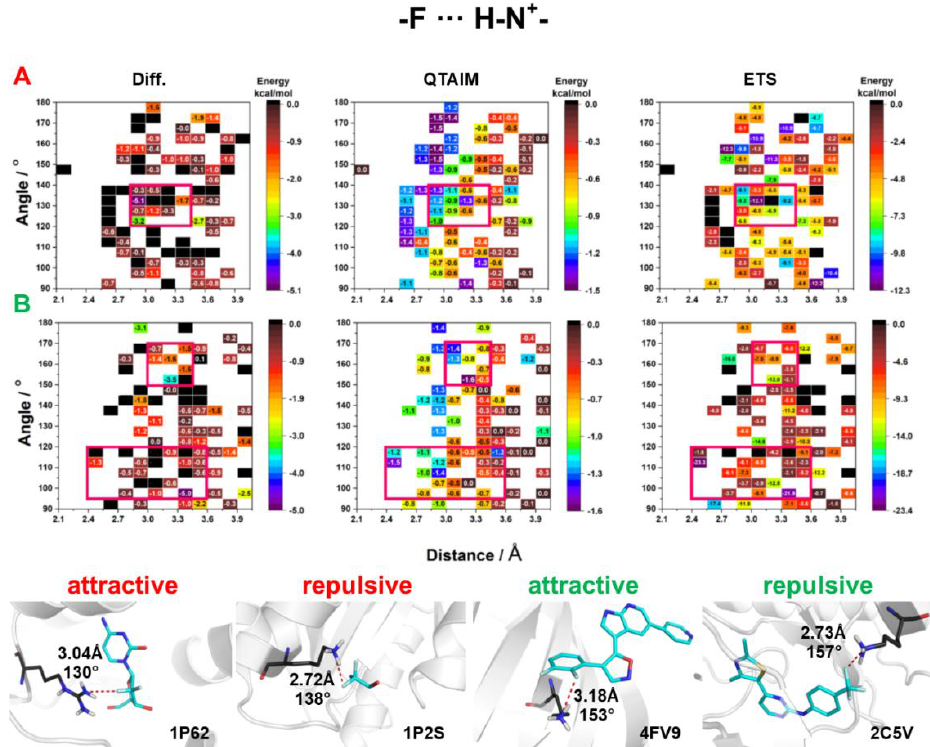
Figure 7. HB energy maps generated based on Diff, QTAIM, and ETS calculations of interaction energy between positively charged NH donor and fluorine attached to ( A ) an aliphatic fragment and ( B ) an aromatic ring for specific geometric parameters. The areas for which the highest stabilizing energy was observed in all three methods are marked with a red square.